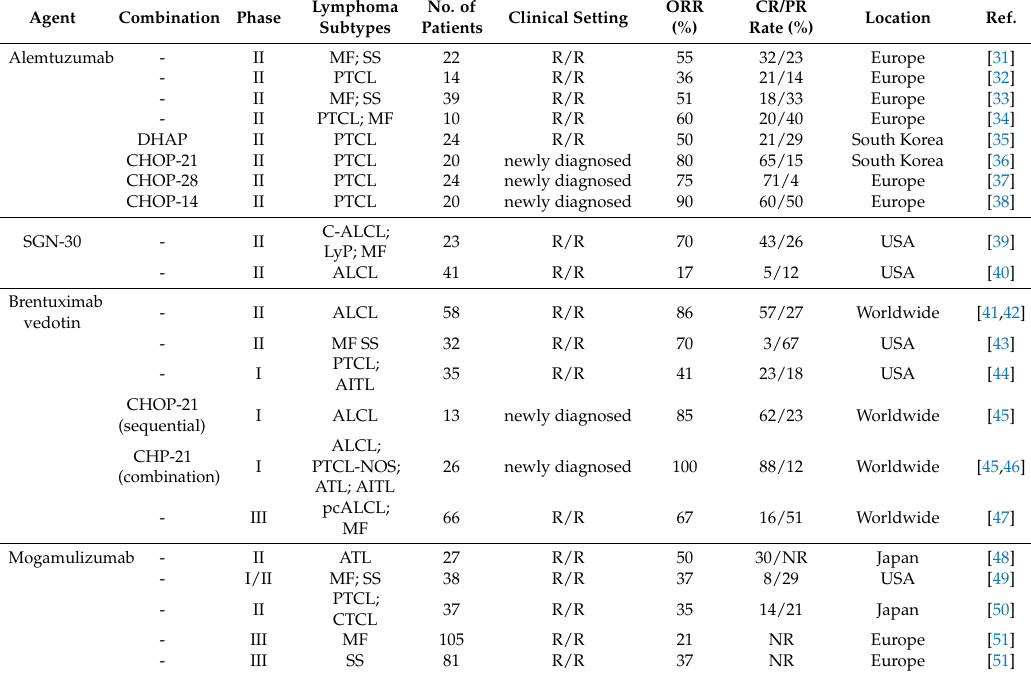
Table 1. Prospective trials of monoclonal antibodies in T cell non-Hodgkin lymphoma